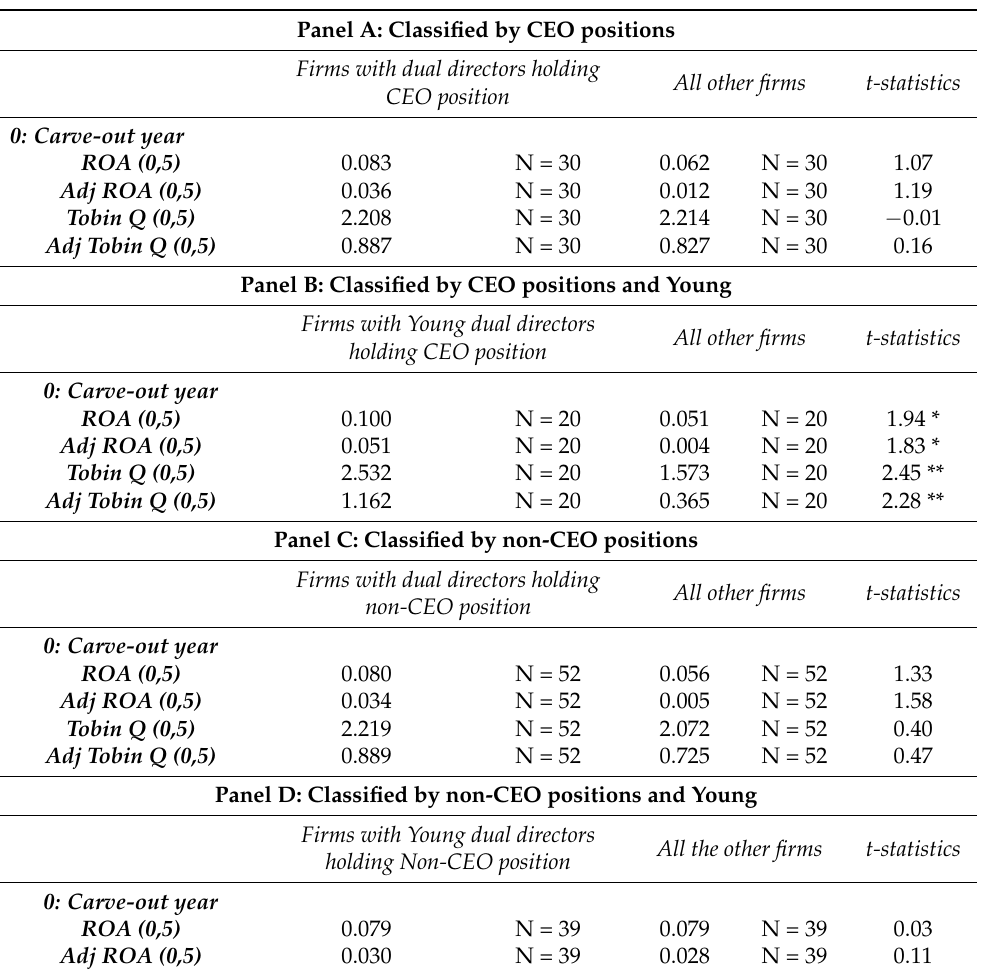
Table A5. Dual directors and subsidiaries’ performance after carve-out. * and ** indicate significance at the 10% and 5% levels,